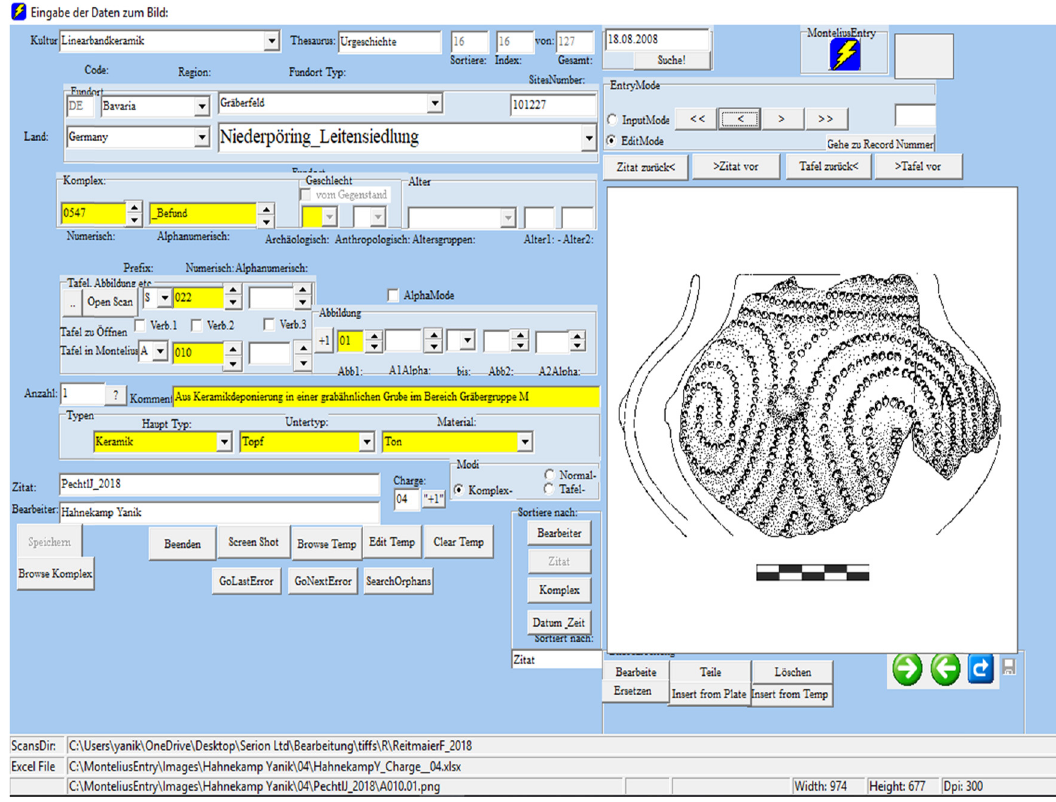
Figure 1: The input mask of the “ Montelius Entry ” function of the Montelius database. A picture is taken from a publication, a basic typology established, and the information then saved to the